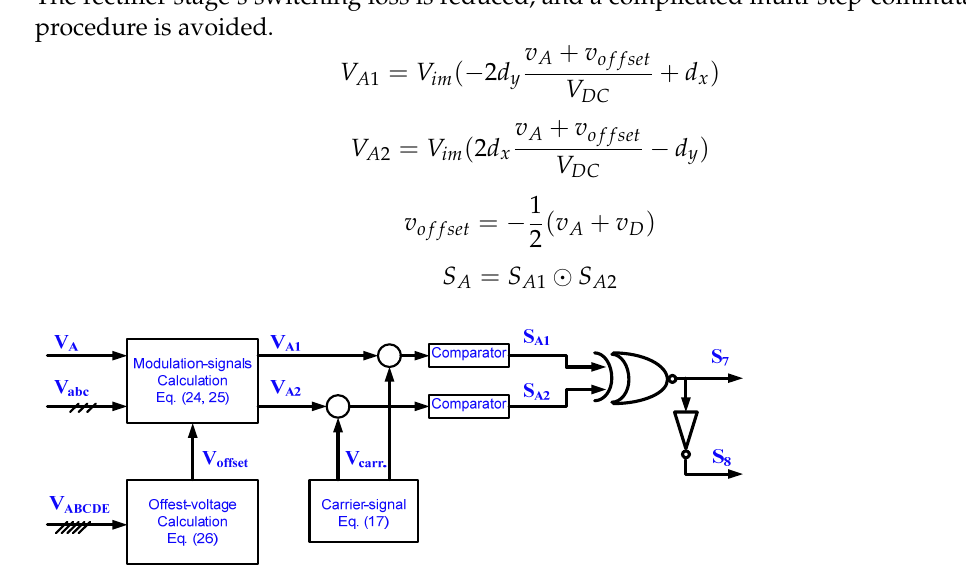
Figure 5. The CBPWM block diagram for the inverter stage in the IMC.